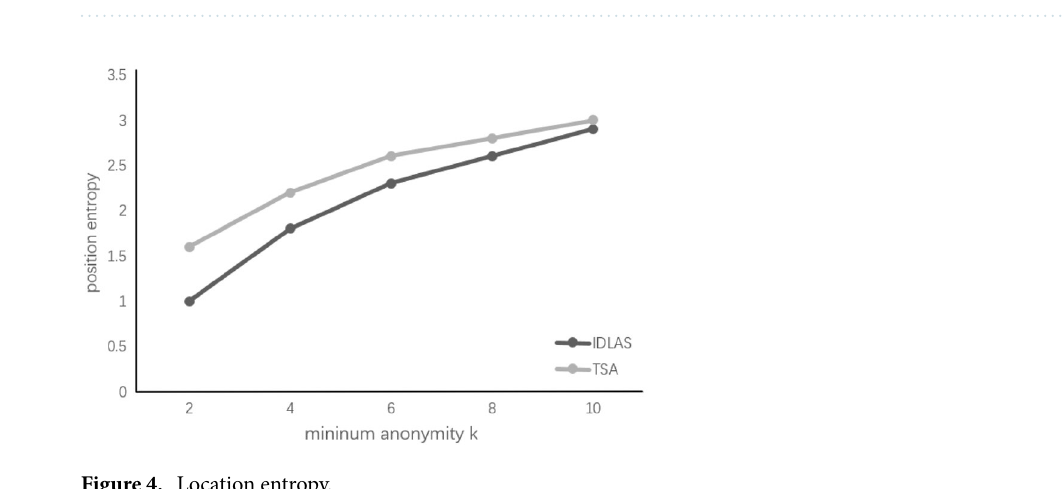
Figure 3. K value on algorithm runtime.